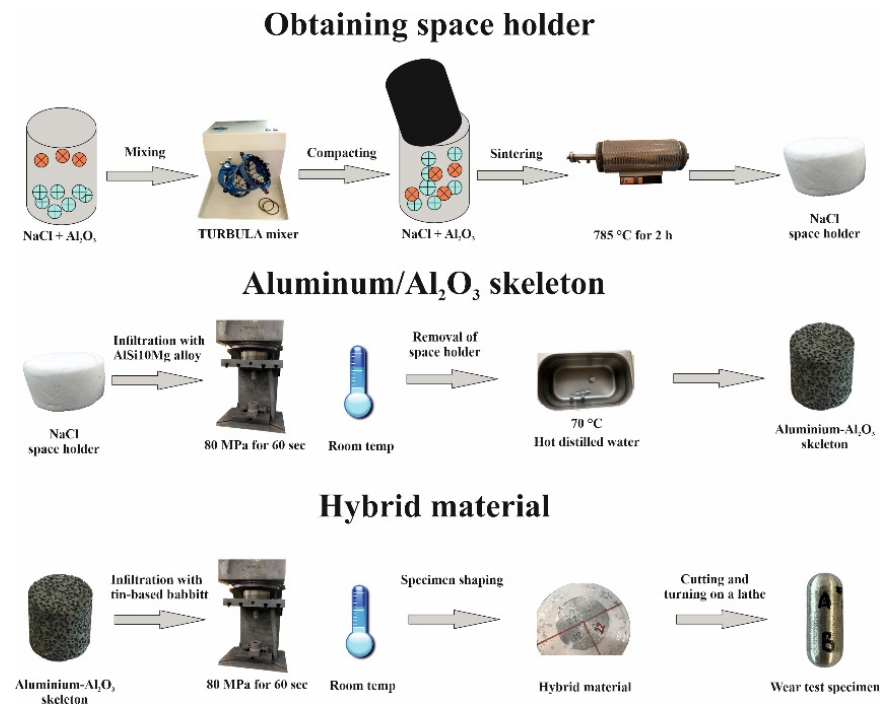
Figure 1. The production process of the hybrid material. Sodium chloride particles with a size range of 430 − 850 µ m are used as space holders to obtain the preforms (Figure 2a). The base alloy for obtaining an aluminum–Al 2 O 3 skeleton with a complex geometry and thin walls is AlSi 10 Mg (see Table 1). The choice of this partic- ular alloy is due to its post-processing flexibility, low weight, and very good